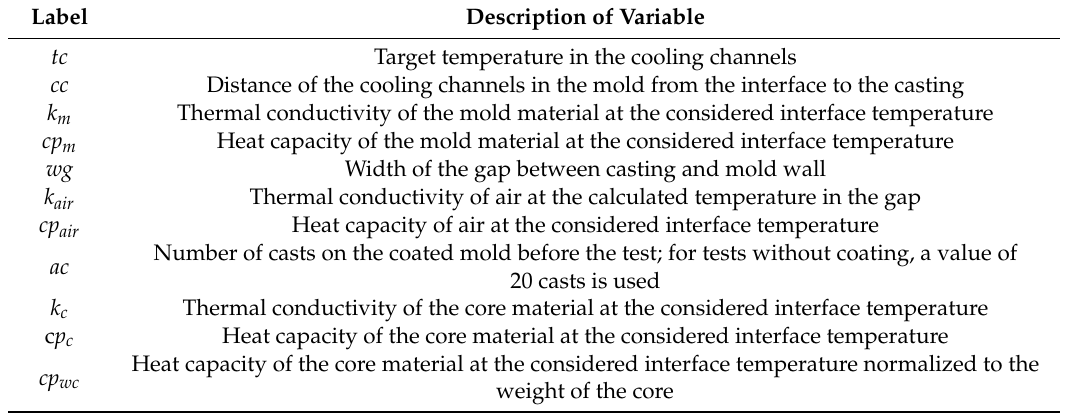
Table 2. Definition of the parameters investigated for influence on the heat transfer coe ffi cient